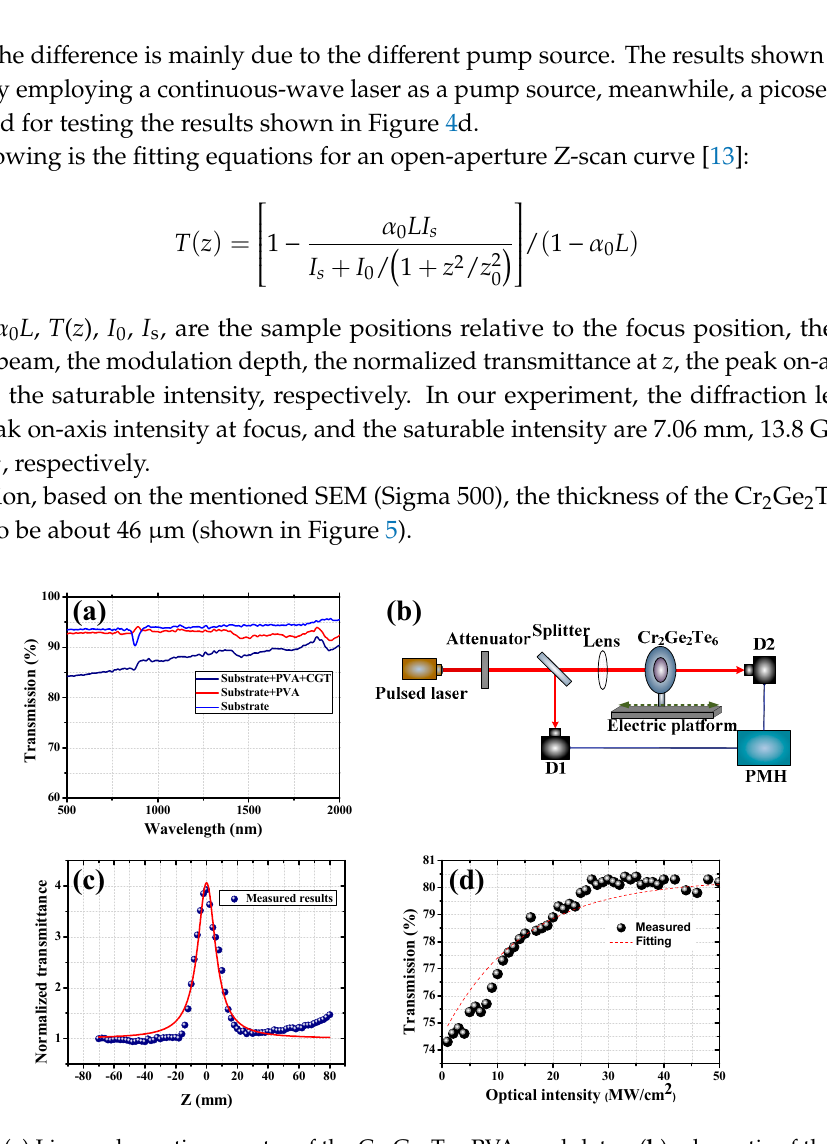
Figure 5. The SEM image of the Cr 2 Ge 2 Te 6 ‐ PVA film.